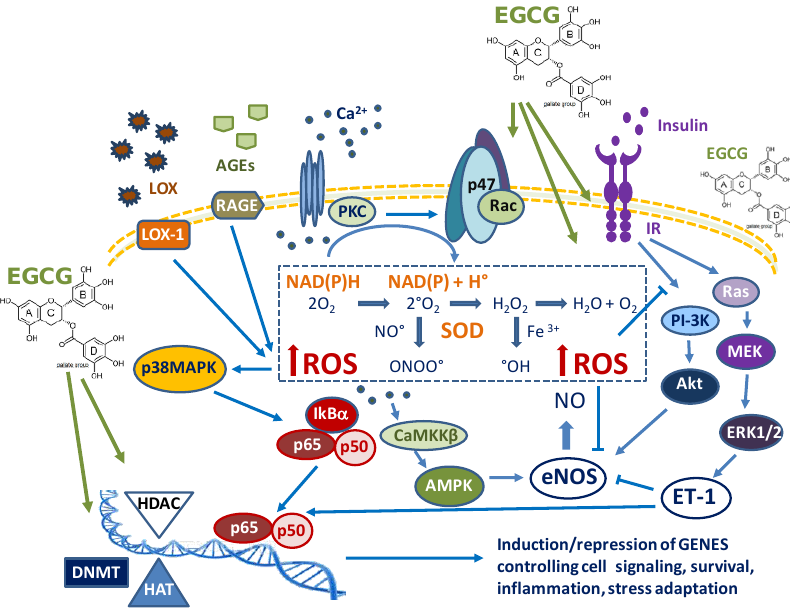
Figure 3. Schematic diagram showing main protective signaling mediated by EGCG in endothelial dysfunction under insulin resistance, lipotoxicity and glycotoxicity. EGCG modulates several signaling pathways, including the insulin receptor-dependent PI3K / Akt pathways and the Ras / MAPK pathways, the p38MAPK and the CaMKK β / AMPK-mediated e ff ects. At the nuclear level, EGCG also inhibits the DNA binding of e ff ector transcription factors, such as NF- κ B and modulates the induction / repression of specific genes by targeting DNA methylation (DNMT), histone acetylase (HAT) and histone deacetylase (HDAC) enzymes. These activities are suggested to involve, in part, an EGCG interference with cellular redox balance and, in part, a direct interaction of EGCG with the catalytic site of endogenous enzymes.